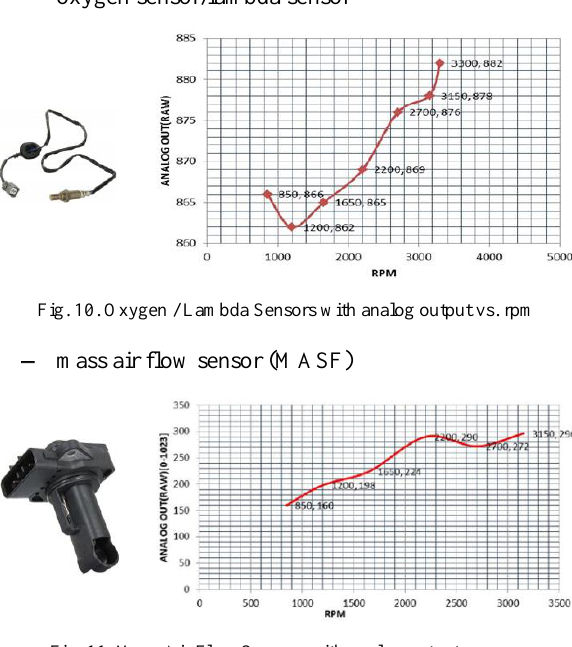
Fig. 11. Mass Air Flow Sensors with analog output vs. rpm